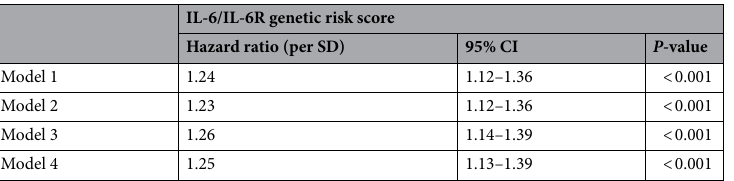
(Fig. 4A,B), as well as the presence of the same SNP in the donor and recipient of a transplant pair (Fig. 4C,D). We, therefore, speculated that assessing the combined presence of multiple polymorphisms, in a genetic risk score, in the donor-recipient pairs could yield more information than examining the polymorphisms individu- ally. To explore the combination of IL6 and IL6R SNPs as predictors of biopsy-proven rejection, we created a genetic risk score of the two variants in both the donors and recipients. Weight was added to each SNP according to their hazard ratio, creating a negative score for protective polymorphisms and a positive score for hazardous ones. Overall, a genetic risk score above zero indicates the presence of more hazardous SNPs in a donor-recipient